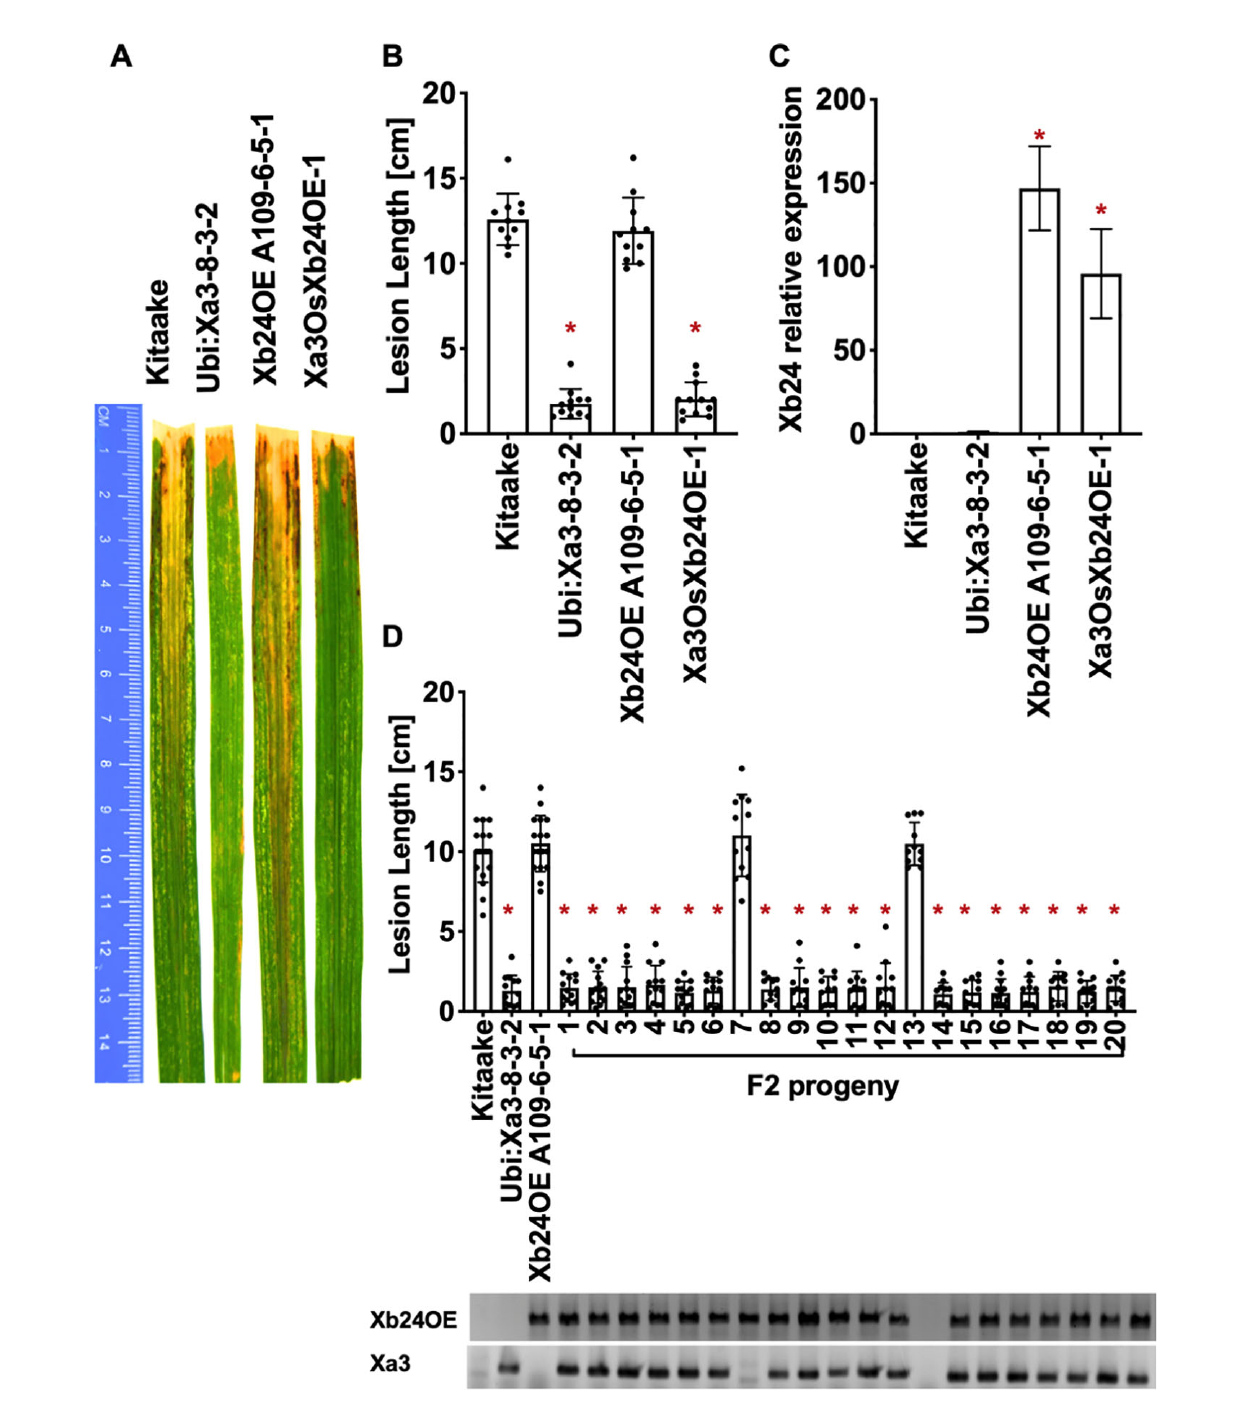
FIGURE 7 | OsXB24 is not required for XA3-mediated immunity in the Kitaake genetic background. (A) Photographed 14 days after inoculation with Xoo strain PXO79. The inoculation method was described in Figure 1 . Control lines used were Kitaake, Ubi : Xa3-8-3-2 and OsXb24OE A109-6-5-1 . (B) The average lesion length data of the inoculated leaves (n = 8 – 12). “ * ” indicates a statistically signi fi cant difference from Kitaake using Dunnett's test ( a = 0.05). (C) The qRT-PCR result shows that OsXb24 is highly expressed in the inoculated F1 plant ( Xa3OsXb24OE-1 ). Relative gene expression measurement is represented as the average of three biological replicates. “ * ” indicates a statistically signi fi cant difference from Kitaake using Dunnett's test ( a = 0.05). (D) The average lesion length data of the inoculated F2 segregating population. Kitaake, Ubi : Xa3-8-3-2 and OsXb24OE A109-6-5-1 were used as control lines. Bars represent mean lesion length on 8-12 leaves. “ * ” indicates a statistically signi fi cant difference from Kitaake using Dunnett's test ( a = 0.05). PCR genotyping for the OsXb24OE construct and Xa3 transgene are shown below the bar